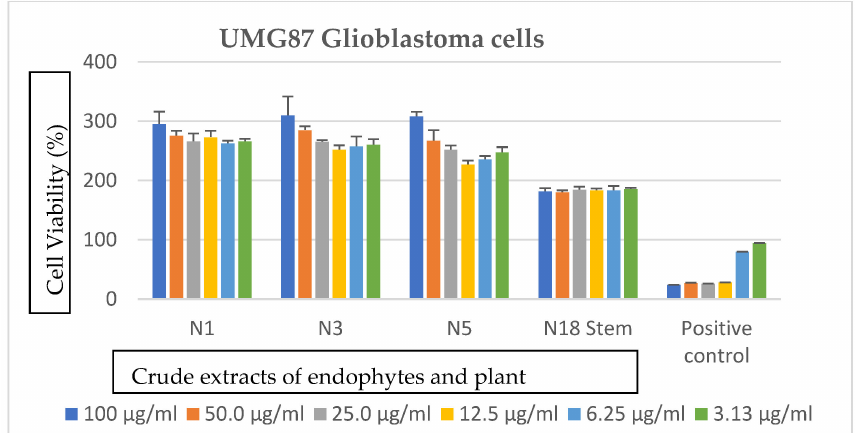
Figure 3. Cytotoxic effects of crude secondary metabolites from the stem of S. mauritianum and its bacterial endophytes on UMG87 glioblastoma cells tested at different concentrations ranging from 100–3.13 µ g/mL. Auranofin was used as positive control. N1 = P. ananatis , N3 = P. eucalypti , N5 = P. vagans , and N18 = S. mauritianum